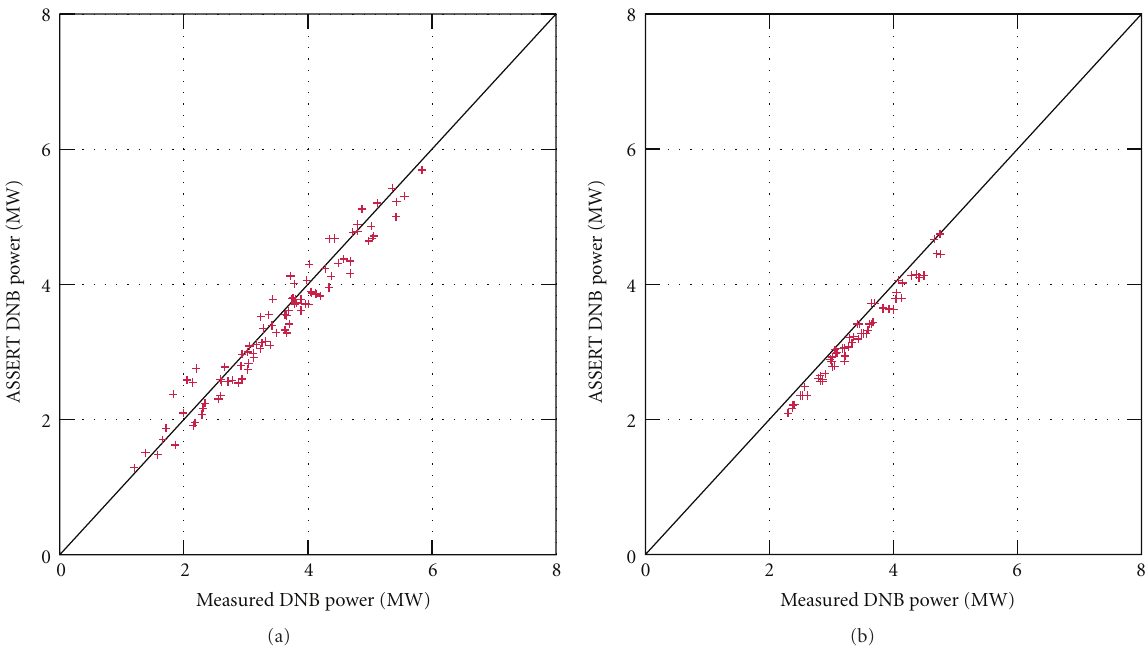
Figure 17: Steady state departure from nucleate boiling results for test series A8 (a) and A13 (b). The estimated uncertainty on the power measurements is 2 σ exp = 2% and is not illustrated in the figure.